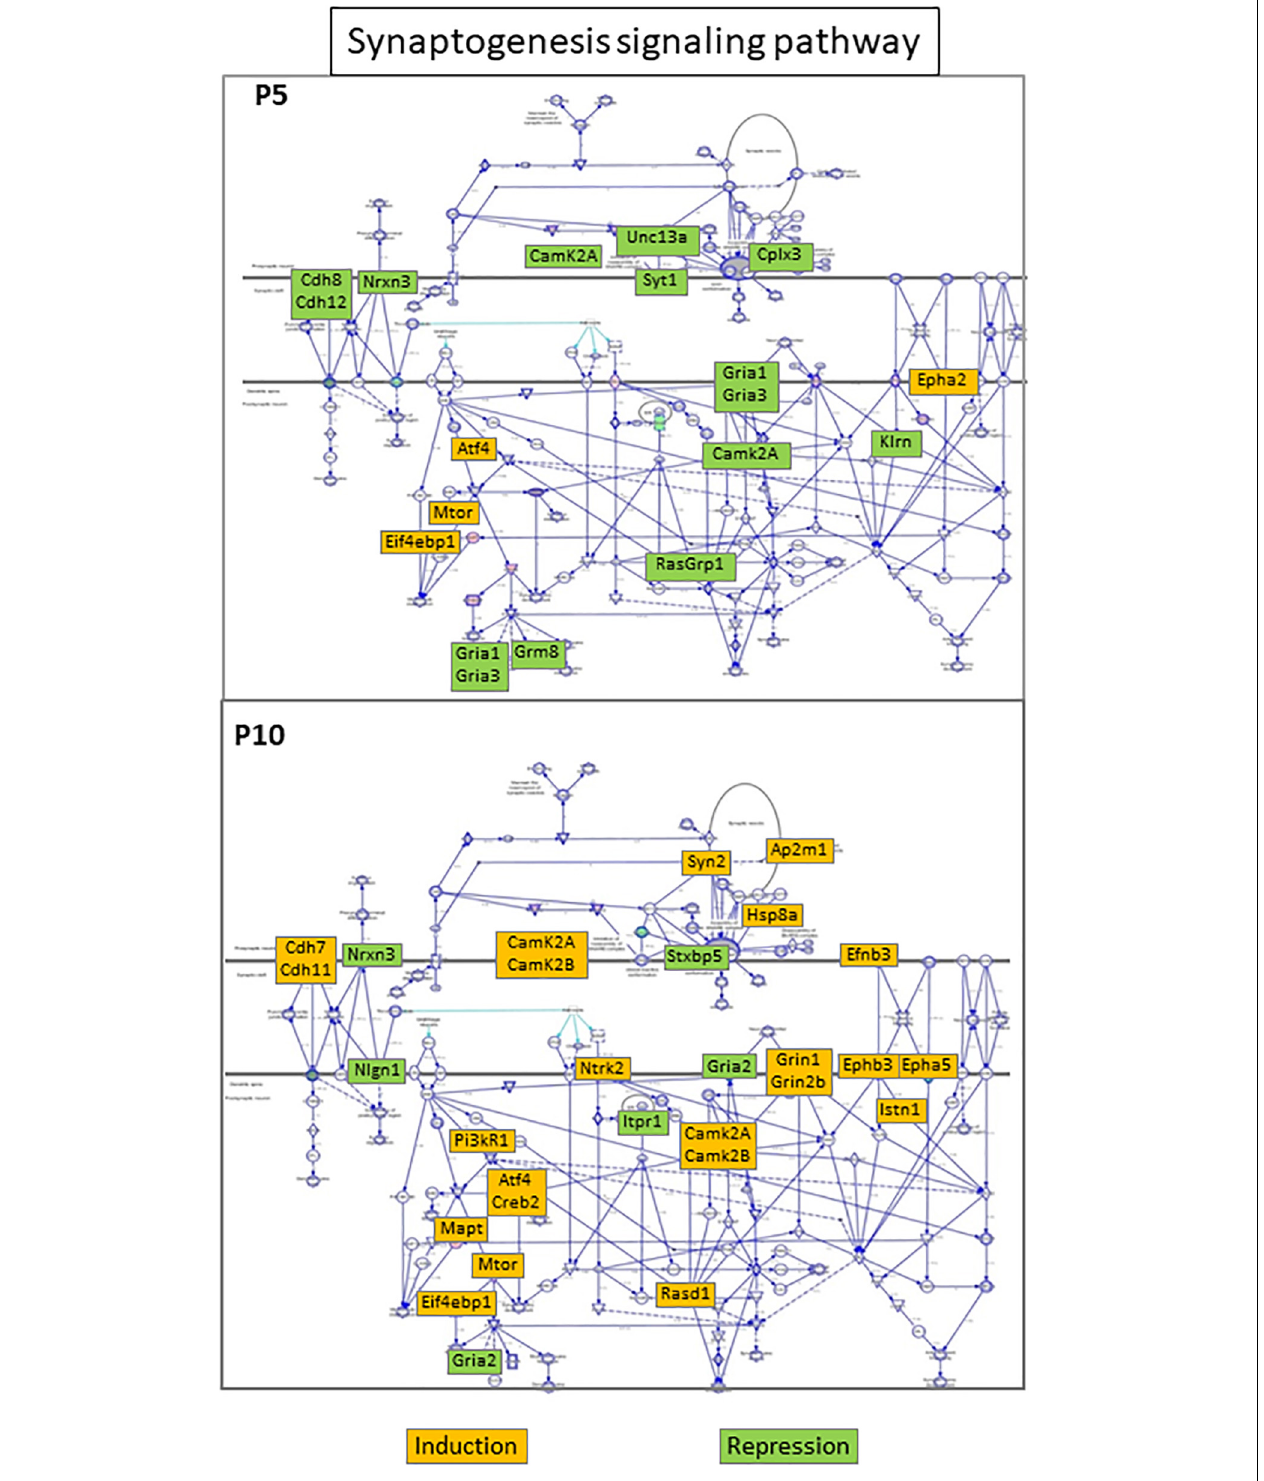
FIGURE 6 | “Synaptogenesis signaling” seIPA-path schematic representation in HI exposed P5 (upper panel) and P10 brains (lower panel) . The pathway was inhibited in the P5 brain and activated in the P10 brain. Color code insets indicate the regulation direction of regulated genes.